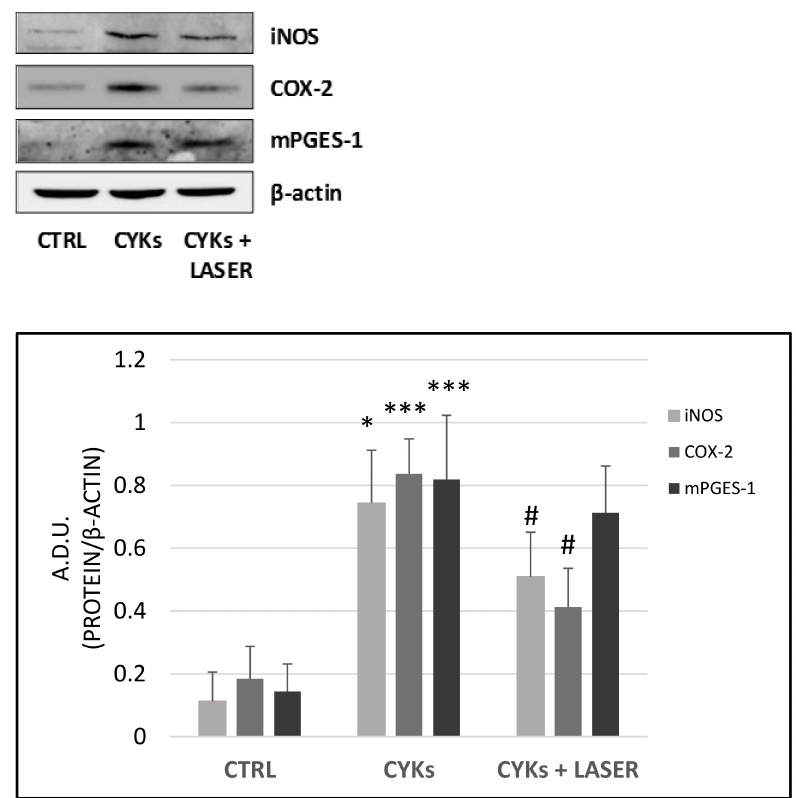
Figure 2. Effect of laser treatment on NDHF cells stimulated with pro-inflammatory cytokines. Fibroblasts were treated with IL-1 β and TNF- α , each at 10 ng/mL for 48 h, then culture medium was replaced by fresh culture medium and samples divided into 3 groups: CYKs + Laser—samples stimulated with cytokine mix and then exposed to laser treatments (3 treatments, repeated once a day, for 3 consecutive days); CYKs—samples stimulated with cytokine mix and not exposed to laser treatment; CTRL—samples not stimulated and not exposed to laser treatment. Six hours after the third laser treatment, whole cell lysates of all samples were collected, and Western blot was performed to assess protein abundance of iNOS, COX-2, and mPGES-1 (upper panel). Immunoblots were analyzed by densitometry and the results, expressed as arbitrary density units (A.D.U.), were normalized to β -Actin (lower panel). Data represent means +/ − SD ( n = 2) * p < 0.05 and *** p < 0.001 CYKs group vs. CTRL group, # p <0.05 CYKs + Laser group vs. CYKs